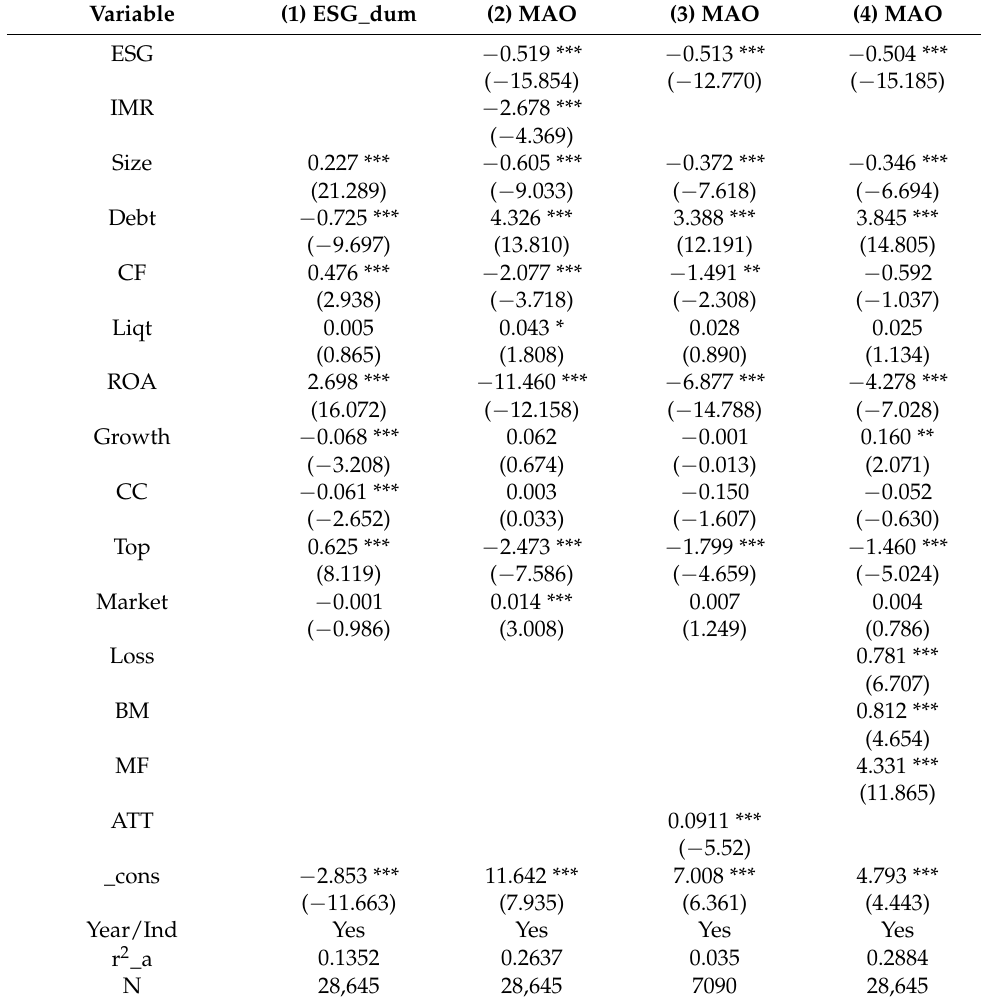
Table 7. Heckman correction method/PSM/addition of control